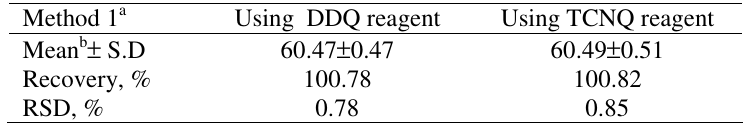
Table 3. Analysis of DLX in capsules ( n